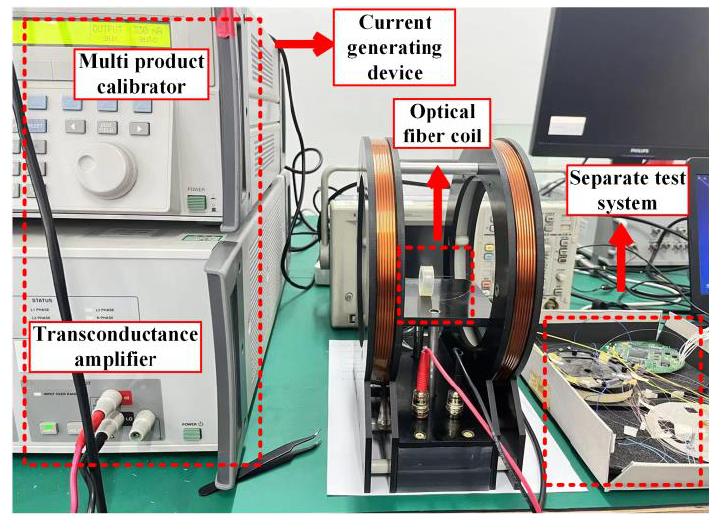
Figure 11. Magnetic error test experiment of axial magnetic field.